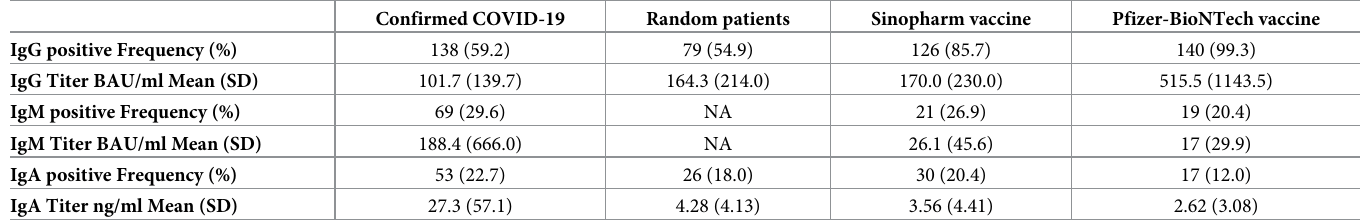
Table 2. COVID-19 immunoglobulins response for COVID-19 confirmed patients (n = 233), Pfizer-BioNTech vaccine recipients (n = 141), Sinopharm vaccine recipients (n = 147), and random patients (n = 144).